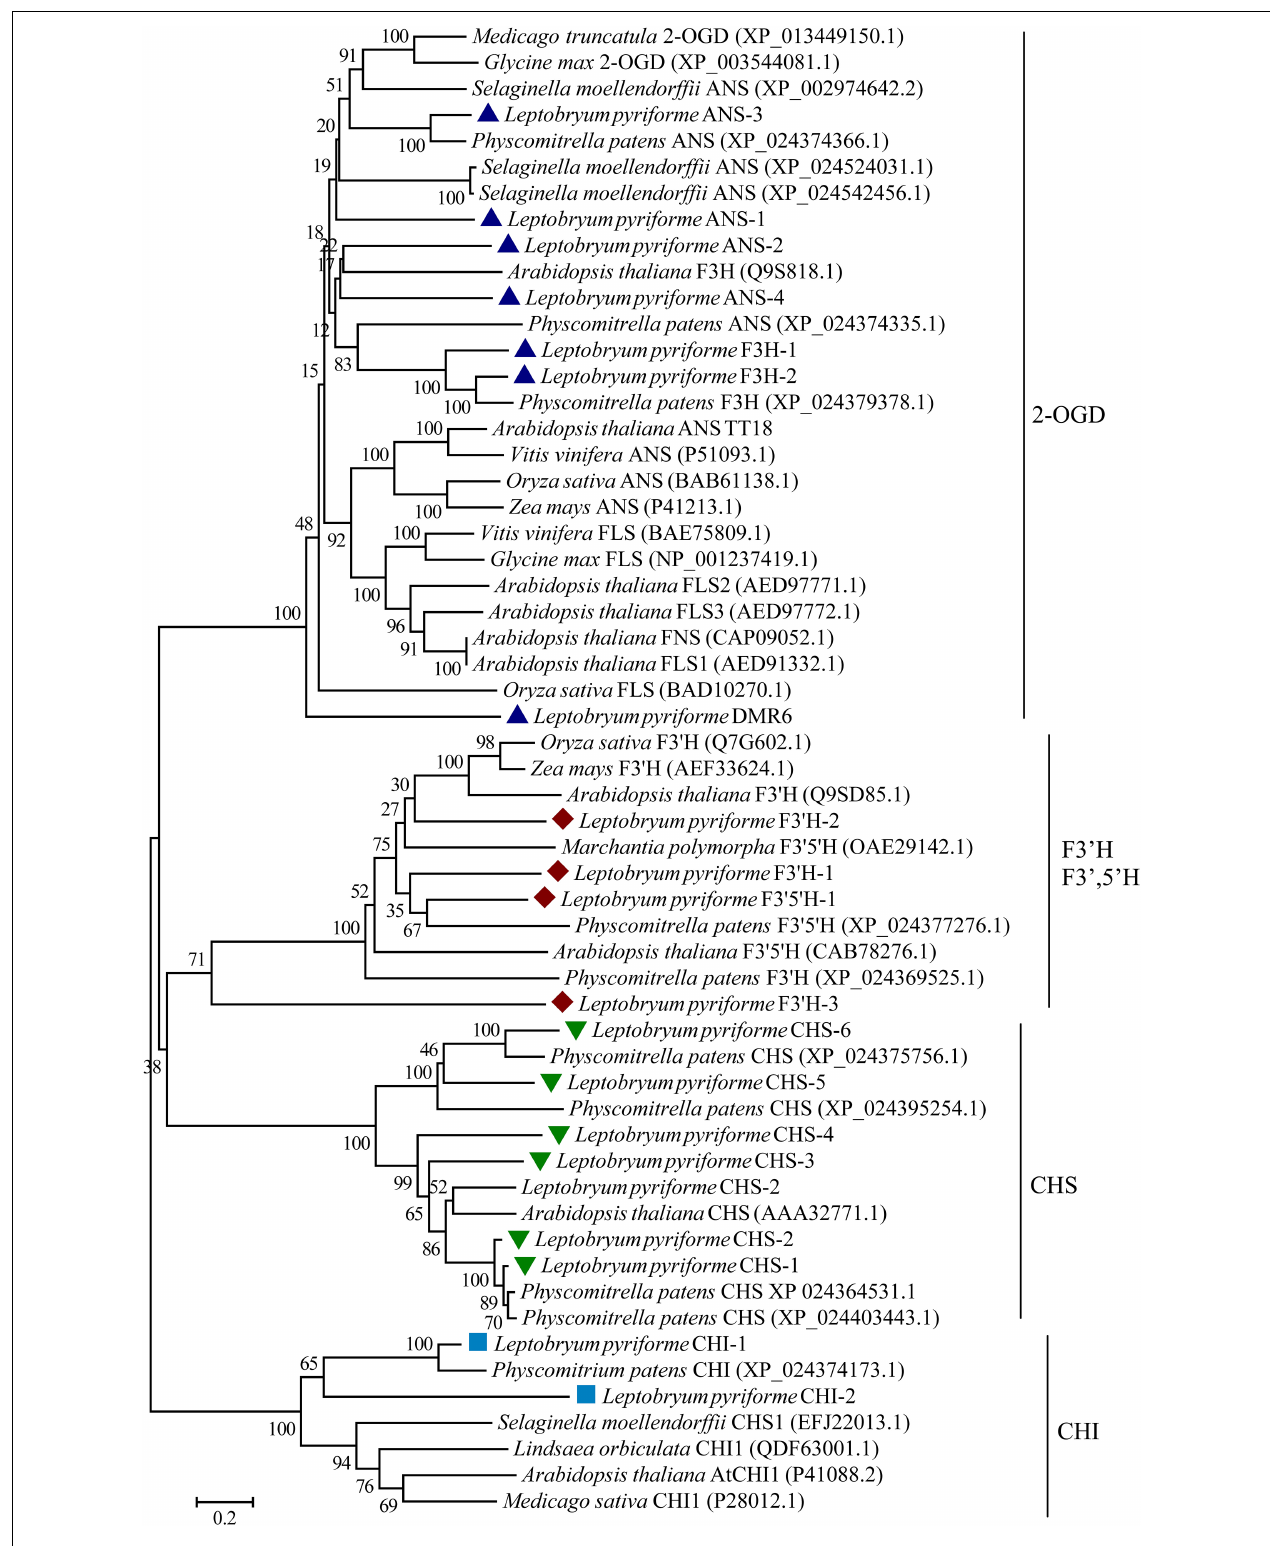
FIGURE 5 | Phylogenetic relationship of flavonoid biosynthesis-related enzymes in representative plants. 2-OGD, 2-oxoglutarate-dependent dioxygenase; ANS, anthocyanidin synthase; CHS, chalcone synthase; CHI, chalcone isomerase; F3H, flavanone 3-hydroxylase; FNS, flavone synthase; FLS, flavonol synthase; F 3 (cid:48) H, flavonoid 3 (cid:48) -hydroxylase; F3 (cid:48) ,5 (cid:48) H, flavonoid 3 (cid:48) ,5 (cid:48) -hydroxylase.